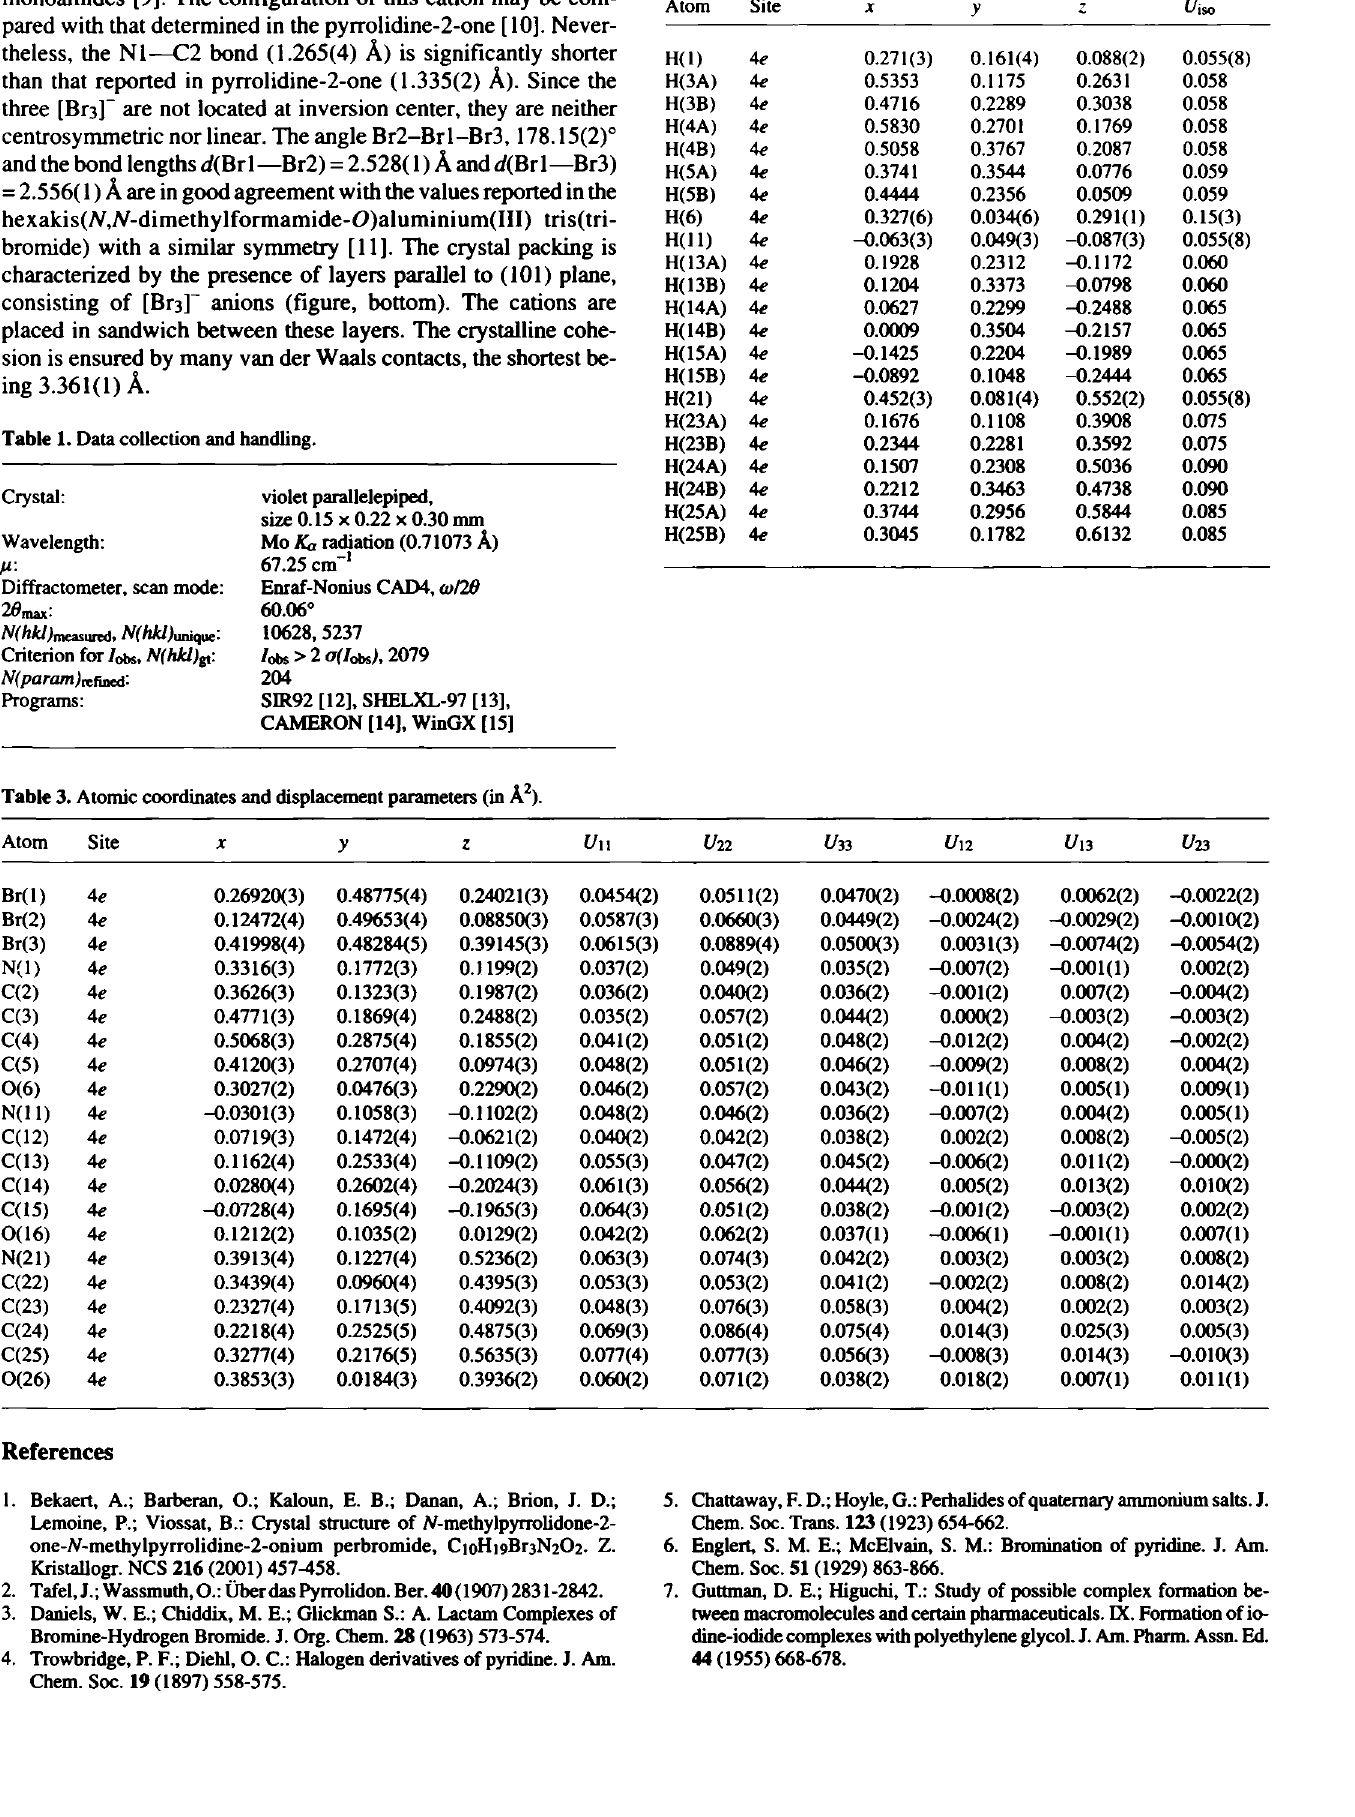
Table 1. Data collection and handling.